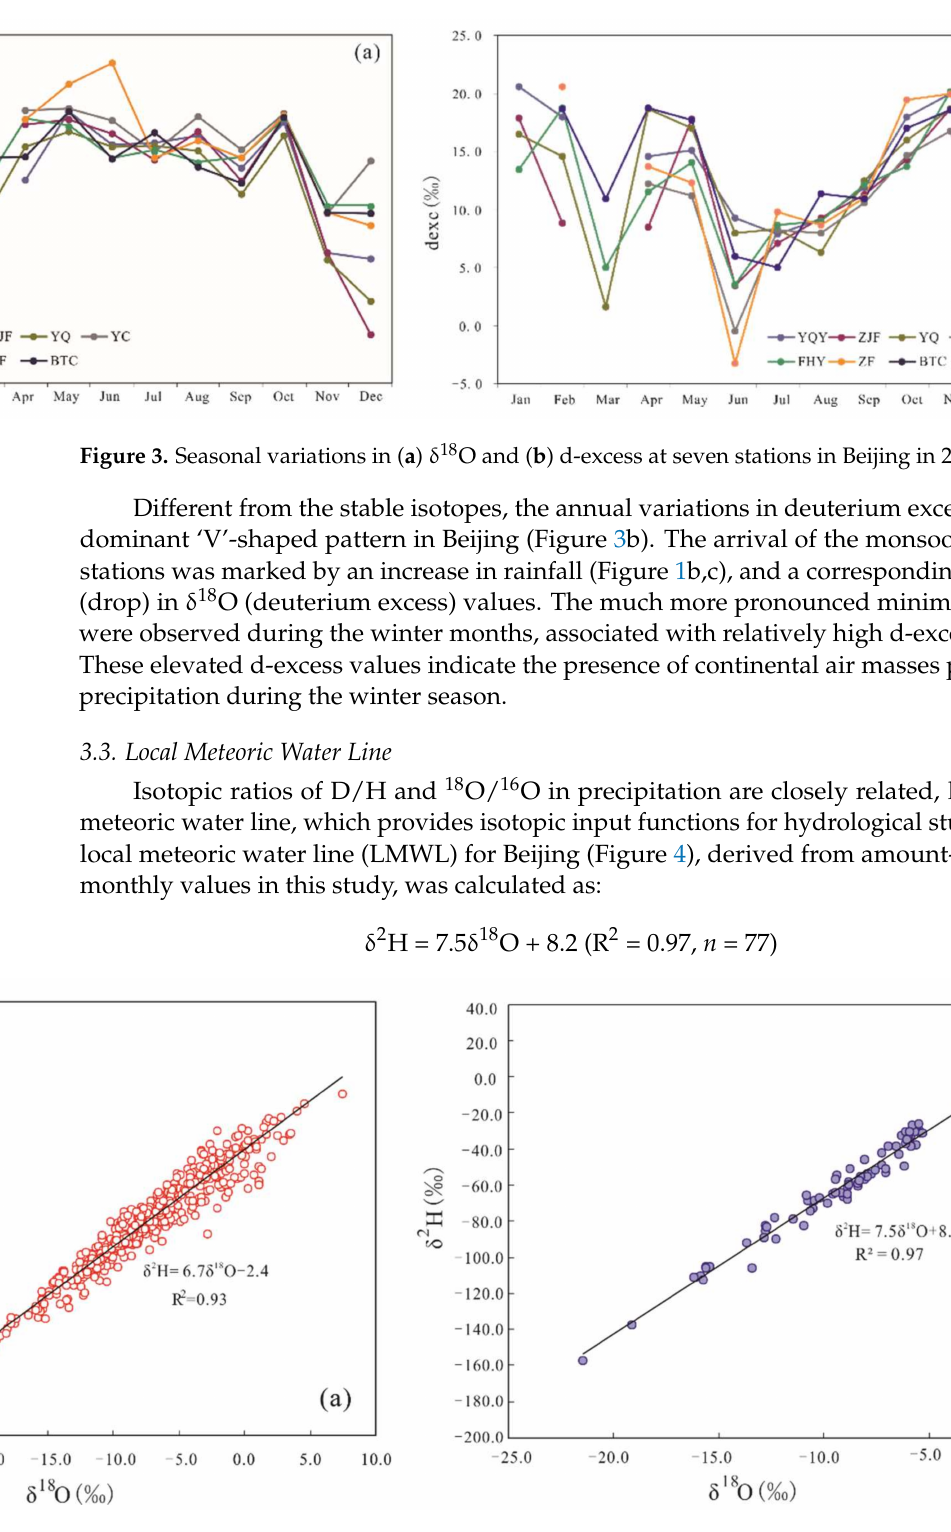
Figure 4. Correlation between δ 2 H and δ 18 O values for Beijing precipitation in 2015: ( a ) δ 2 H and δ 18 O values of individual samples ( n = 539): δ 2 H = 6.7 δ 18 O − 2.4; and ( b ) monthly amount-weighted average δ 2 H and δ 18 O values ( n = 77): δ 2 H = 7.5 δ 18 O +